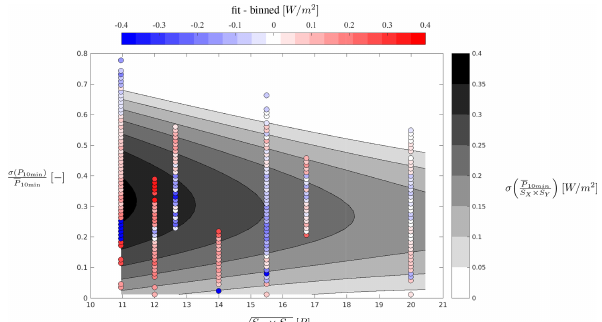
Figure 10. Contours based on multiple linear regression fit of stan- dard deviation of the bin-averaged power production per area to the standard deviation of power production normalized by mean power production and relative turbine spacing. Points mark the binned data, where blue and red shades indicate whether the fit underes- timates or overestimates, respectively, the binned averaged values.